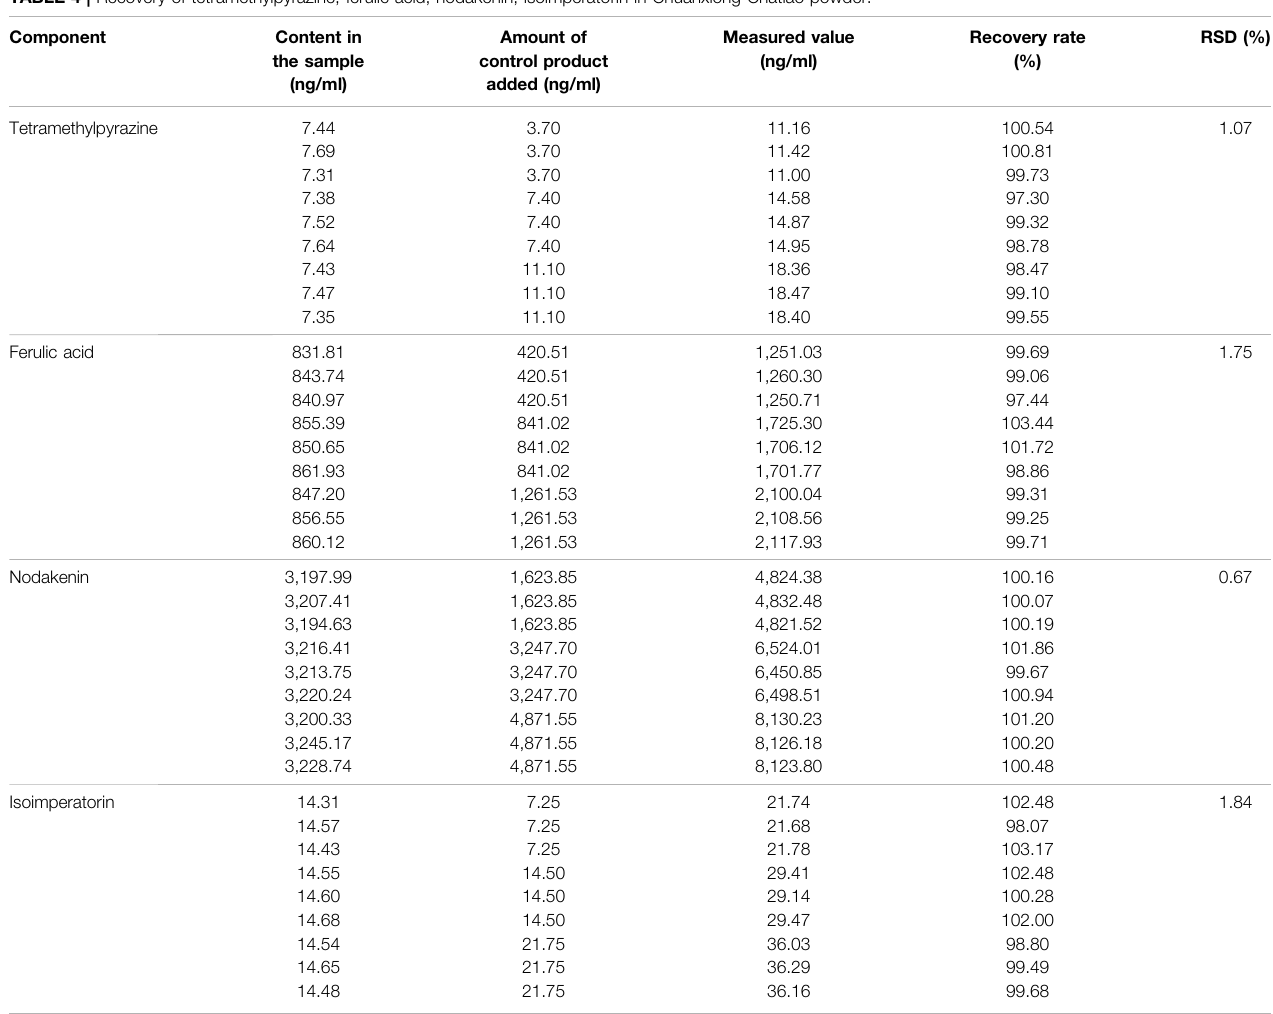
TABLE 3 | Regression equation and linear range of the standard curve of tetramethylpyrazine, ferulic acid, nodakenin, and isoimperatorin. Component